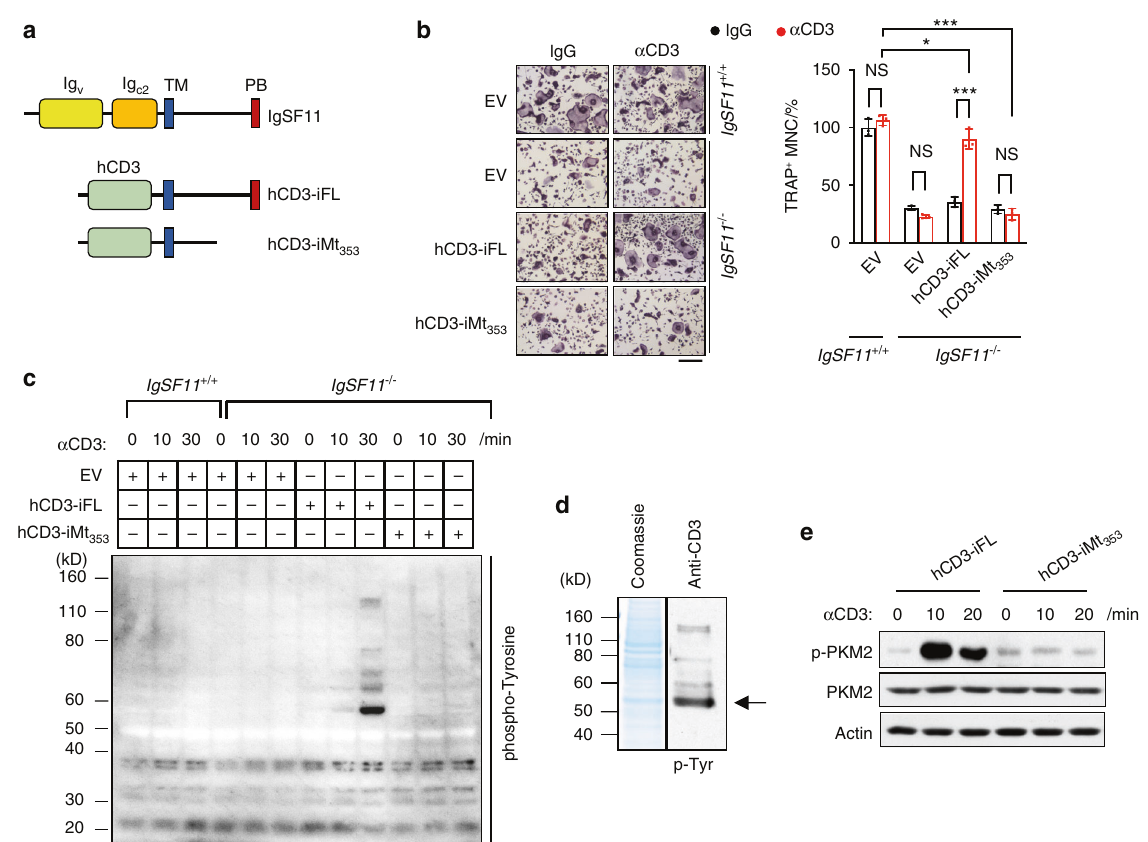
Fig. 1 Stimulation of IgSF11 induces the phosphorylation of pyruvate kinase M2. a Schematics of IgSF11 (top), the human CD3 extracellular- transmembrane region fused to the full IgSF11 intracellular region (hCD3-iFL) (middle), and the IgSF11-Mt 353 intracellular region (hCD3-iMt 353 ) (bottom) chimeric proteins. The hCD3-iFL and hCD3-iMt 353 mutants were used for retroviral transduction of IgSF11 − / − BMMs. All constructs were Flag-tagged at the C-terminus. TM; transmembrane domain, PB; PDZ binding domain. b IgSF11 − / − BMMs were retrovirally transduced with the indicated vectors, cultured with M-CSF + RANKL in the presence of anti-hCD3 antibody or control IgG and stained for TRAP. The frequency of TRAP + multinucleated cells (3 nuclei or more per cell) is shown. Scale bars represent 100 μ m. EV; empty vector. The data are presented as the means ± S.D. Each dot represents a technical replicate. c Tyrosine phosphorylation downstream of IgSF11. IgSF11 − / − BMMs were retrovirally transduced with the indicated vectors, cultured with M-CSF + RANKL for two days and then stimulated with anti-hCD3 antibodies for the indicated times. IgSF11 + / + BMMs that were transduced with an empty vector were used as a negative control. Western blotting was performed with the indicated antibodies. d IgSF11 − / − BMMs were retrovirally transduced with hCD3-iFL, cultured with M- CSF + RANKL for two days and then stimulated with anti-hCD3 antibodies for 30 min. Whole-cell lysates were passed through phosphoprotein af fi nity columns. The eluted fraction was separated by SDS – PAGE, visualized with Coomassie blue R-250 and/or immunoblotted with 4G10. The arrow indicates the protein band that was subjected to mass spectrometry. e IgSF11 induces the phosphorylation of PKM2. IgSF11 − / − BMMs were retrovirally transduced with the indicated vectors, cultured with M-CSF + RANKL for two days and then stimulated with anti-hCD3 antibodies for the indicated times. Western blotting was performed with the indicated antibodies. The results are representative of at least three independent